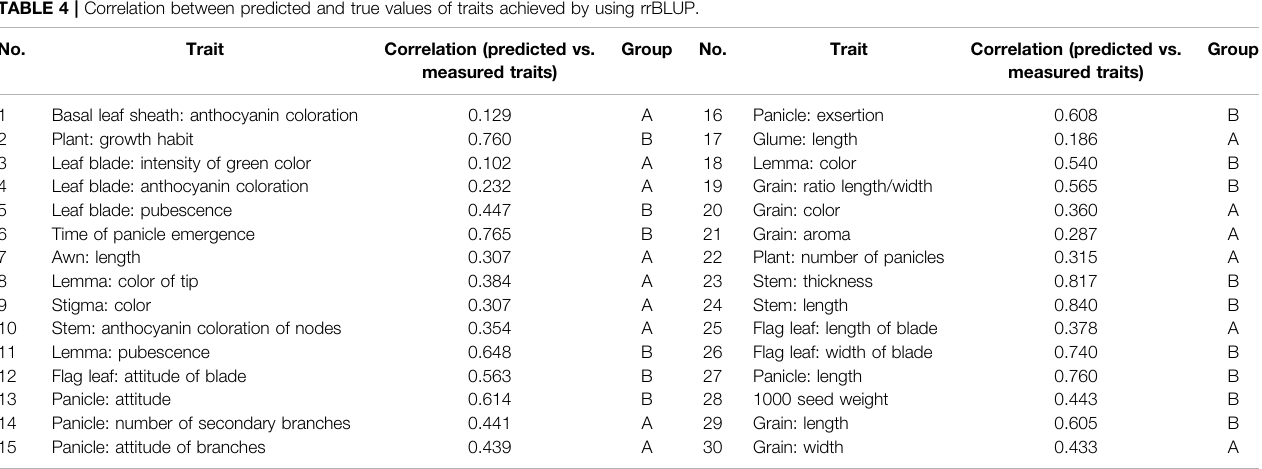
FIGURE 6 | Correlation analysis of trait expression. Only values with a correlation greater than 0.35 or less than − 0.35 are displayed.